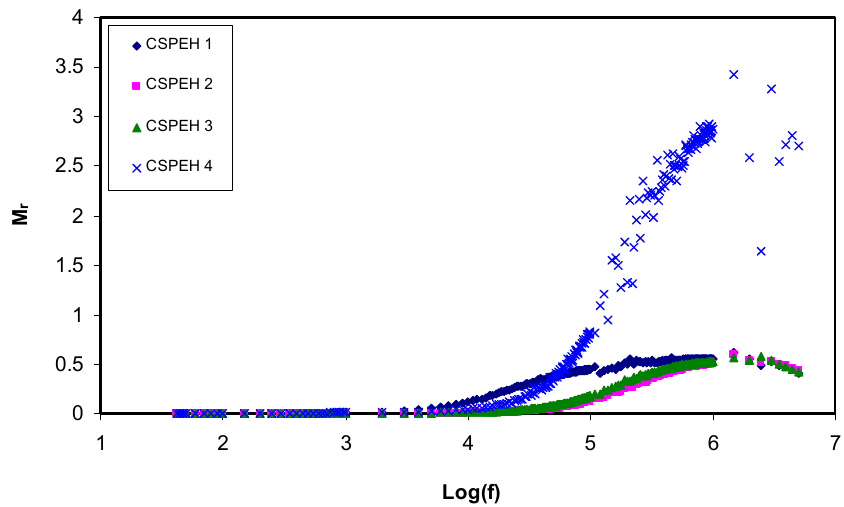
Figure 8. Electric modulus (M r ) real part in opposition to the frequency logarithmic scale for all the electrolytes.